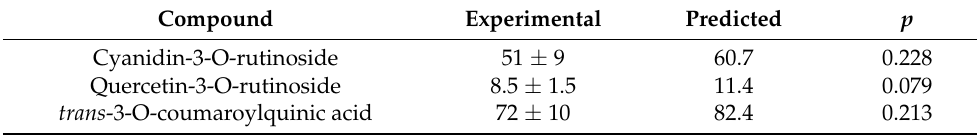
Table 3. Validation test of the three polyphenols extracted under optimized UAE